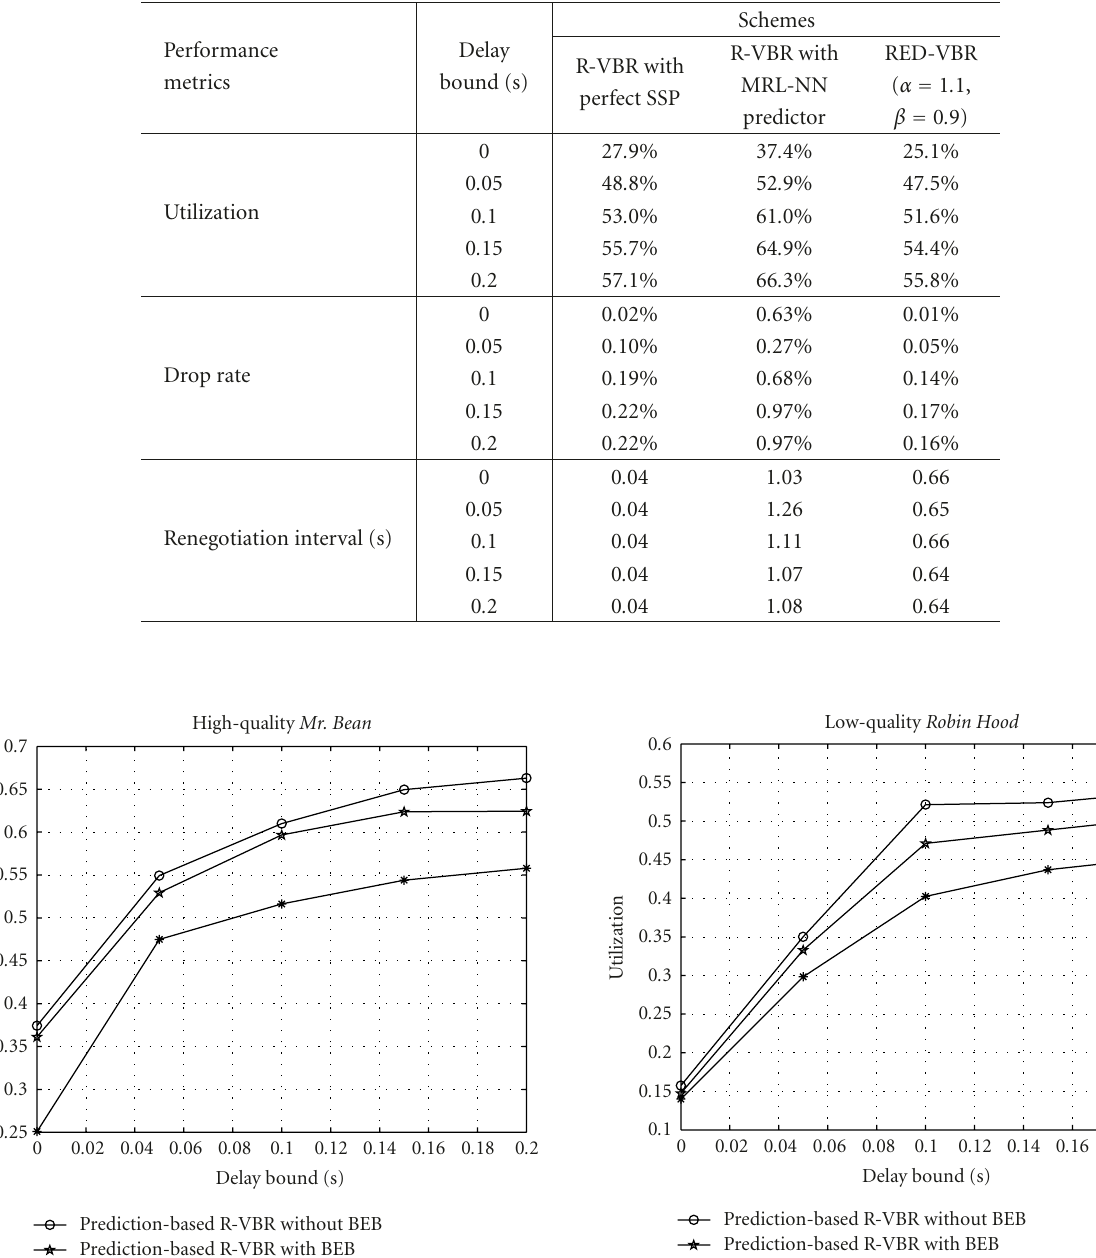
Table 3: R-VBR performance comparisons among perfect single-step-ahead prediction (SSP) based scheme, multistep-ahead prediction MRL-NN based scheme, and RED-VBR scheme.